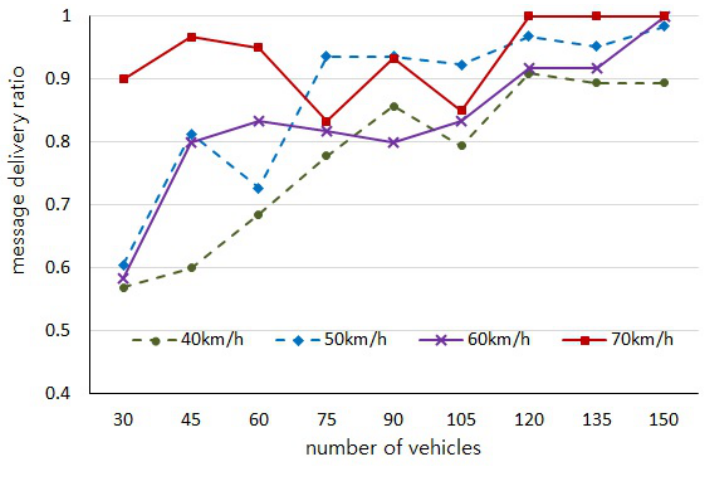
Figure 8. Successful message delivery ratio for the destination